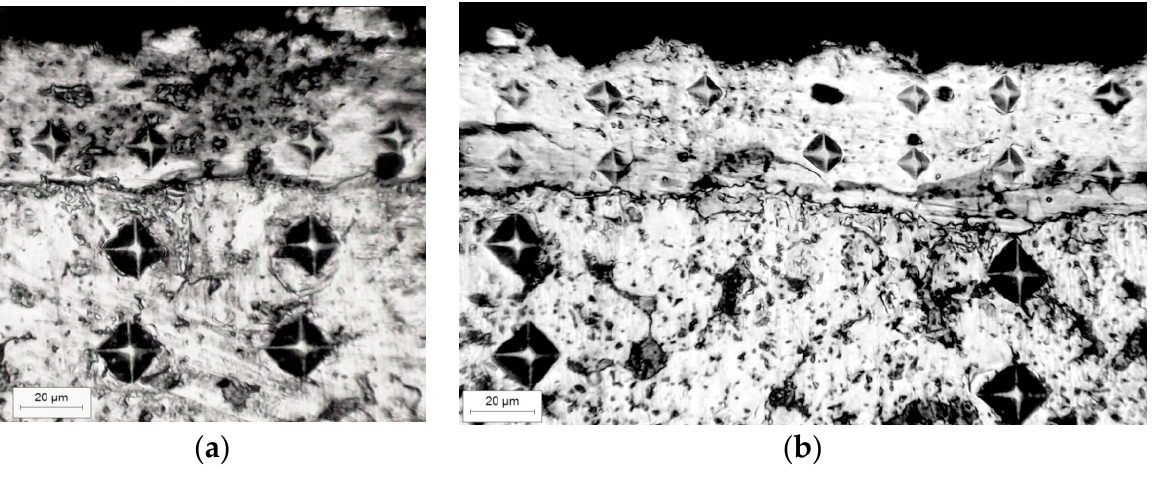
Figure 4. Microstructure of the coating on steel C45, obtained by ESD with the supply of a mixture of titanium and graphite powders to the MEP: ( a ) discharge energy Ер = 0.3 J and ( b ) discharge energy Ер = 0.9 J.